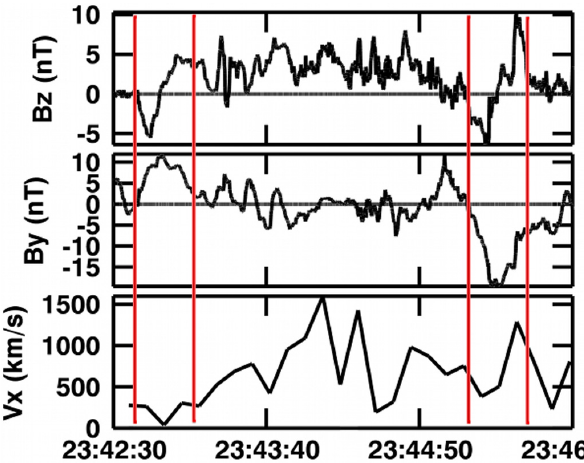
Fig. 9. Data from SC1 in the time interval 23:42:30–23:46:00UT on 19 September 2003. From the top: B z component, B y compo- nent and ion velocity X component. The intervals between the red vertical lines contain the two flux ropes identified in this time pe- riod. Their core fields are of opposite